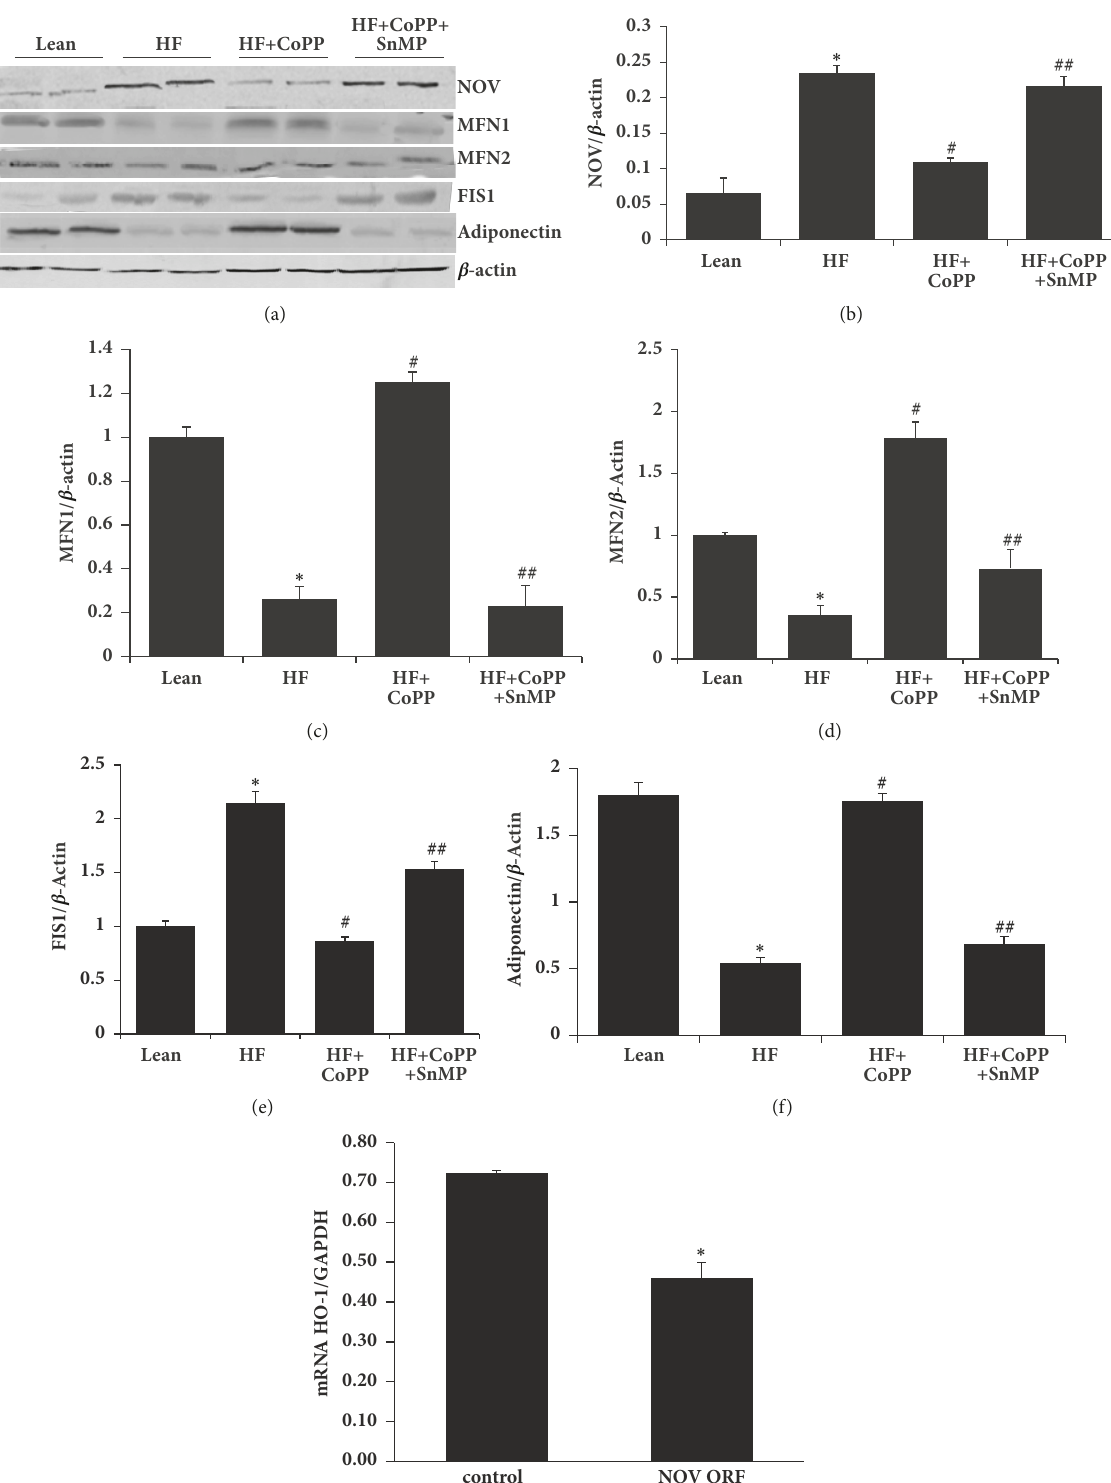
Figure 7: Adipose tissue HO-1 upregulation increases anti-inflammatory adiponectin and mitochondrial fusion-associated proteins, while decreasing proinflammatory NOV and the mitochondrial fission-associated protein, FIS1. (a) Representative western blots, and densitometry analysis of (b) NOV, (c) MFN1, (d) MFN2, (e) FIS1, and (f) adiponectin. (g) HO-1 mRNA levels in NOV overexpressing 3T3-L1 derived adipocytes. Results are mean ± SE, n=4, ∗ p < 0.05 versus lean mice/control, #p < 0.05 versus HF fed mice, and ##p < 0.05 versus HF fed mice +